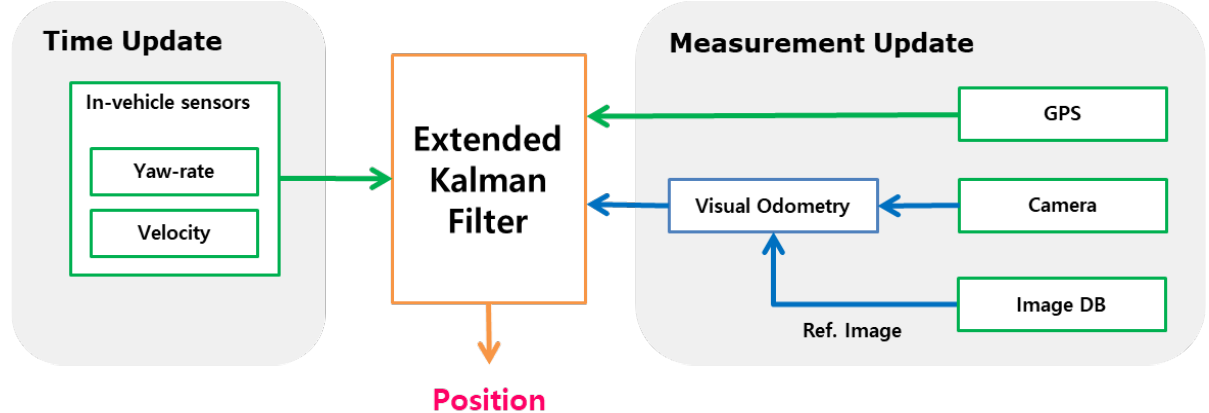
Figure 1. Overall framework of the localization